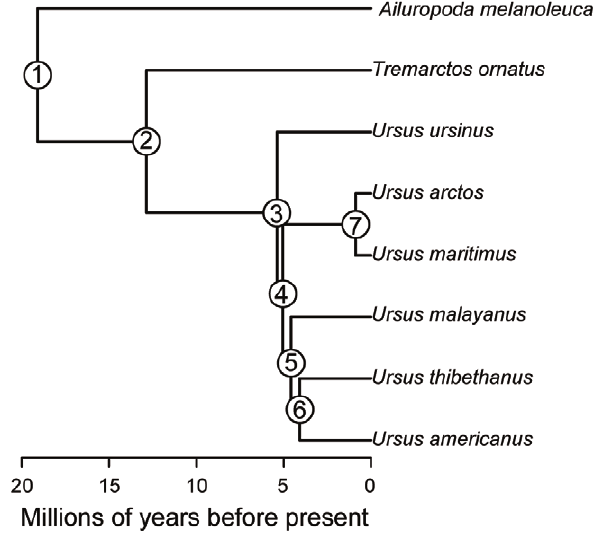
Figure 1. Time-calibrated ursid phylogeny used for assessing rates of cranial shape evolution. Node numbers correspond to those used for evolutionary contrasts (see Table 1).